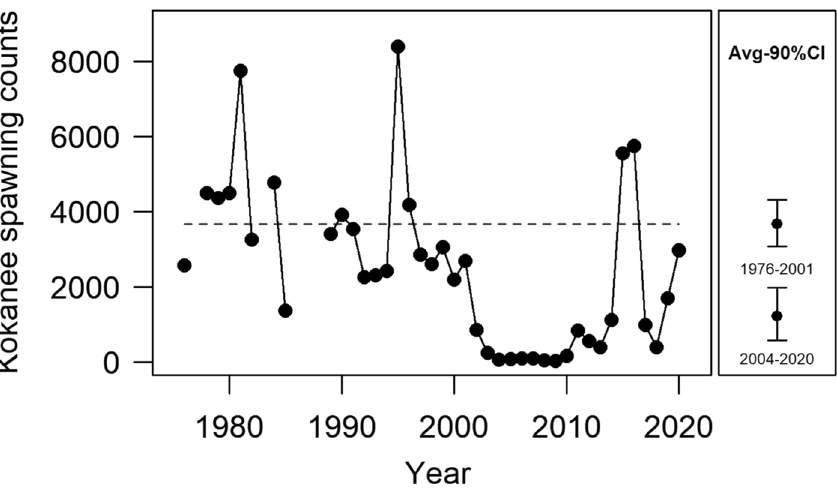
Figure 2. Kokanee spawning counts in Kluane National Park and Reserve, 1973–2020 (Wong, pers. comm) illustrating the annual fluctuations in spawning numbers and severe period of decline from 2002–2014. Data were accessed under the Open Government Licence – Canada (https:// open. canada. ca/ data/ en/ datas et/ 4107d c81- 79c0- 406e- a1e6- 30150 9d9e5